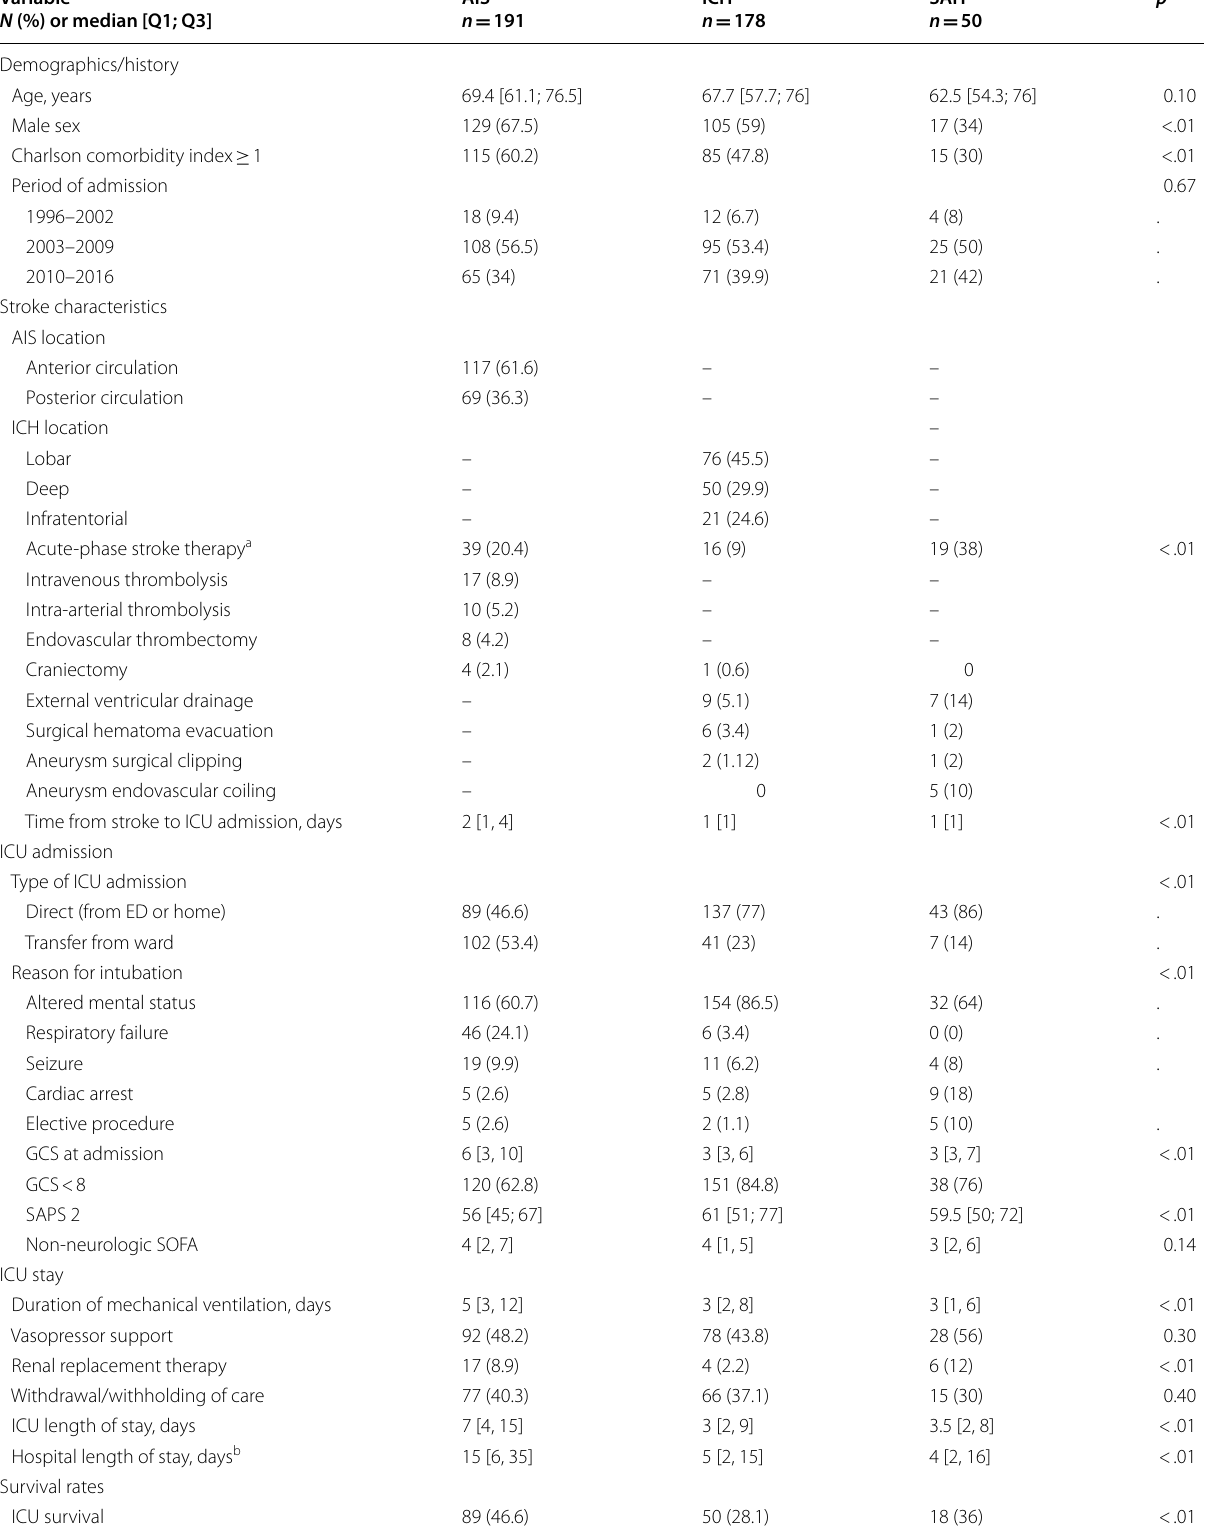
Table 2 Patients characteristics and outcomes, according to stroke subtype Variable N (%) or median [Q1;